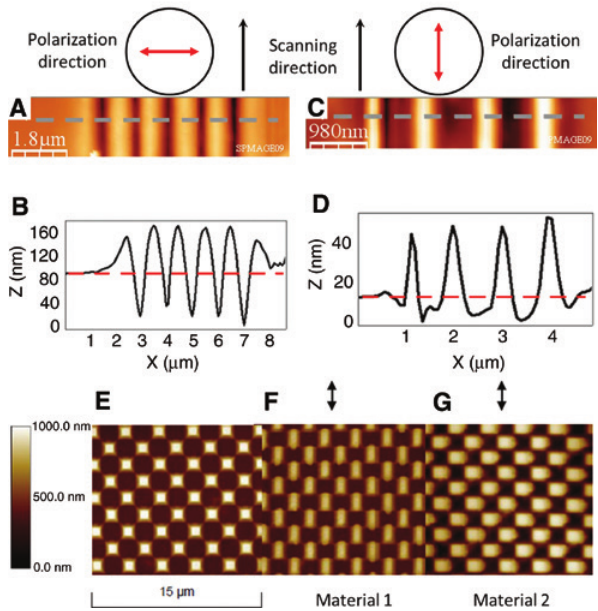
Figure 7: Dependence of the material displacement direction on illumination conditions and chemical nature of azomaterial systems. AFM images and topographic profiles of the surface reliefs gener- ated onto an azopolymer by a scanning focused laser beam linearly polarized in the direction orthogonal (A–B) and parallel (C–D) to the fast scanning direction. Adapted from Ref. [73] with permis- sion from AIP Publishing. (E) A pristine array of square micro-posts (E) deformed in the direction parallel (F) or orthogonal (G) to the linear light polarization depending on the chemical nature of the employed azomaterial. Reproduced with permission from Ref.